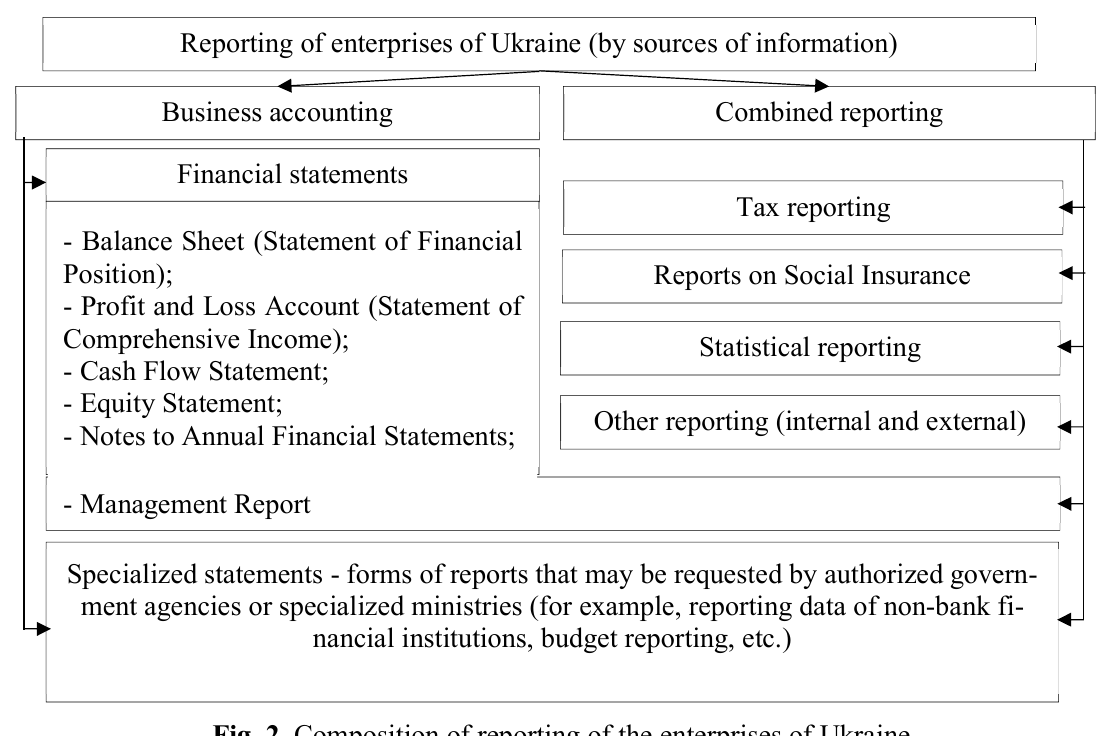
Fig. 2. Composition of reporting of the enterprises of